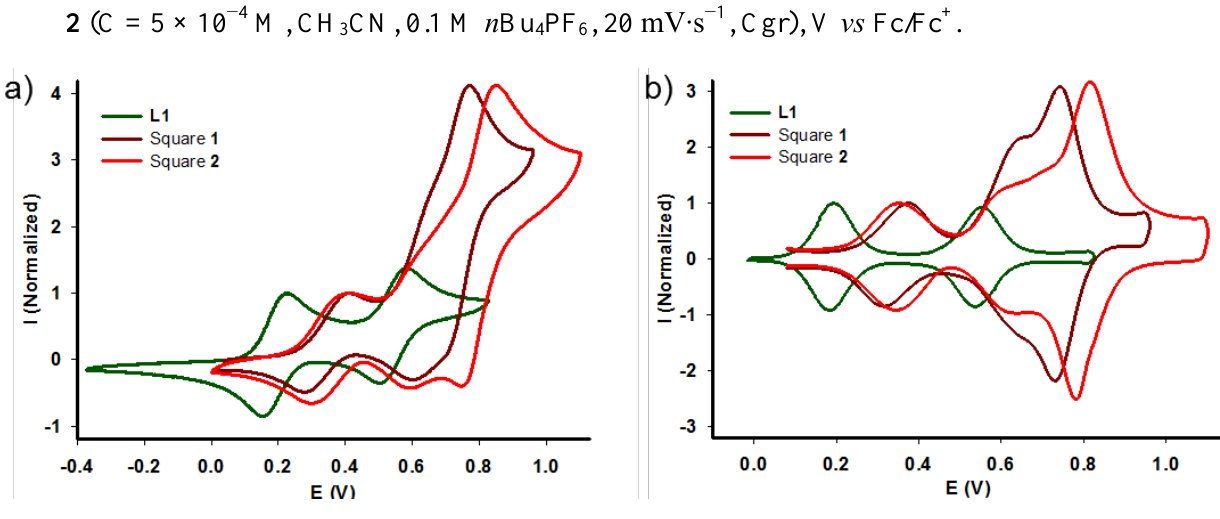
Figure 5. ( a ) Cyclic voltammogram and ( b ) deconvoluted cyclic voltammogram of ligand L1 (C = 10 −3 M, CH 2 (C = 5 × 10 −4 M, CH